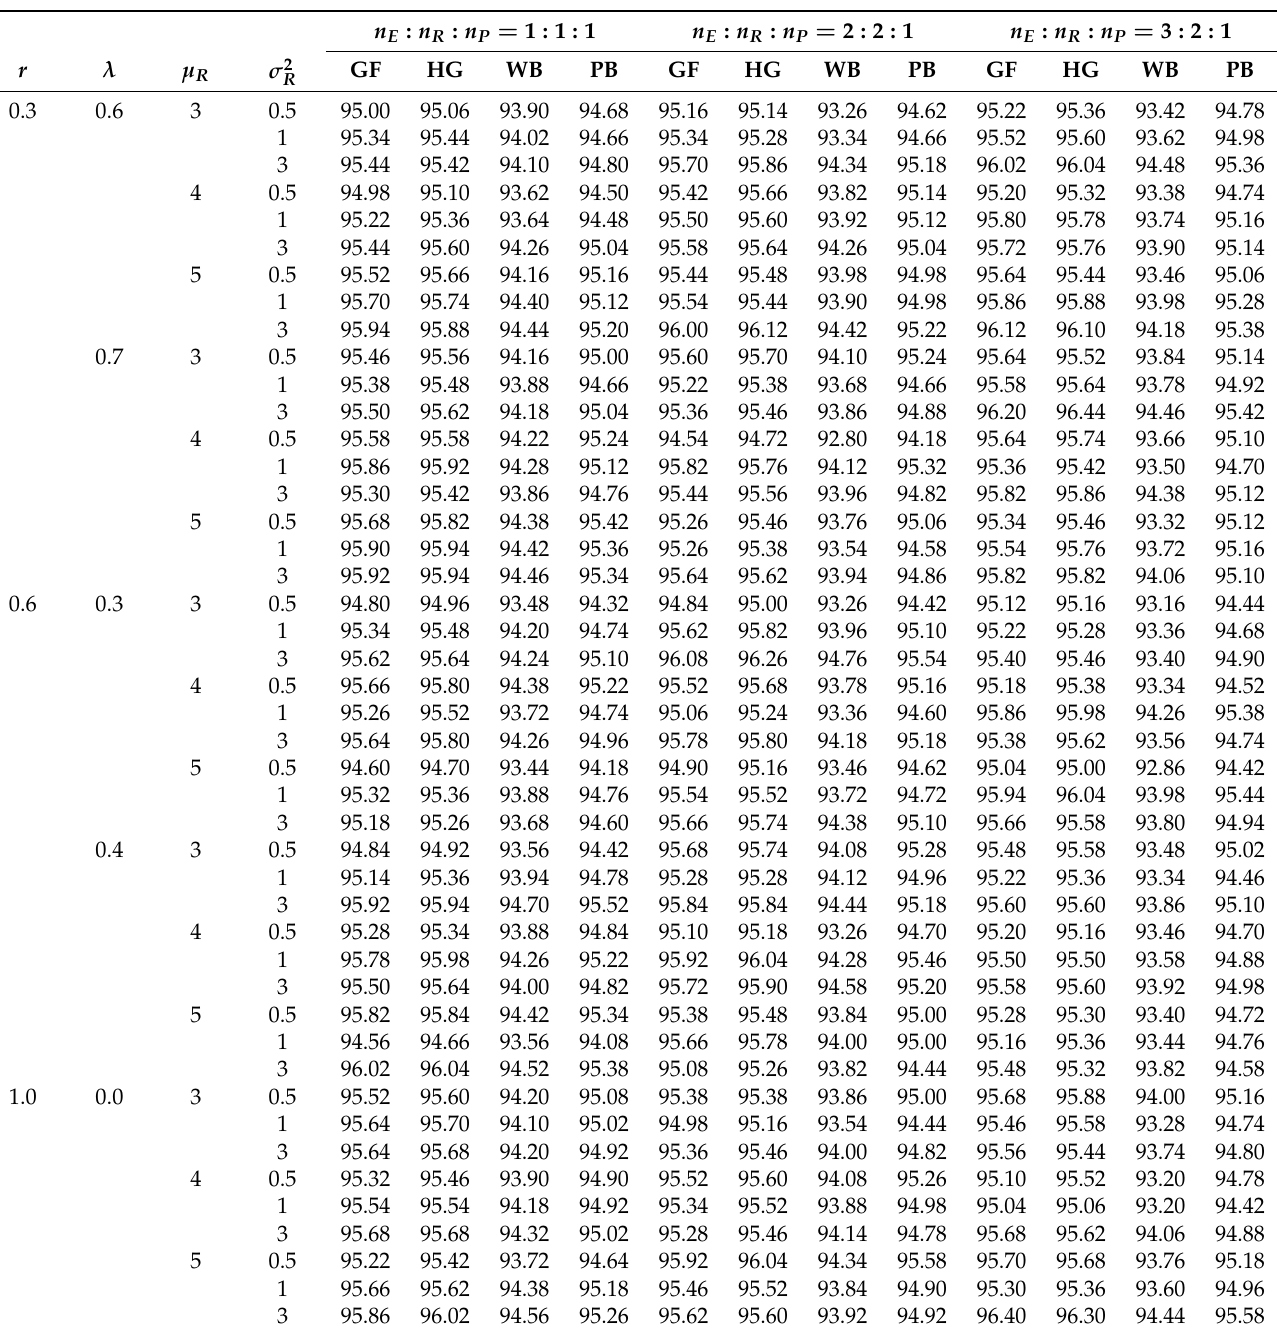
Table 1. Empirical coverage probabilities of four 95% simultaneous confidence regions for φ and ψ under various settings with n =